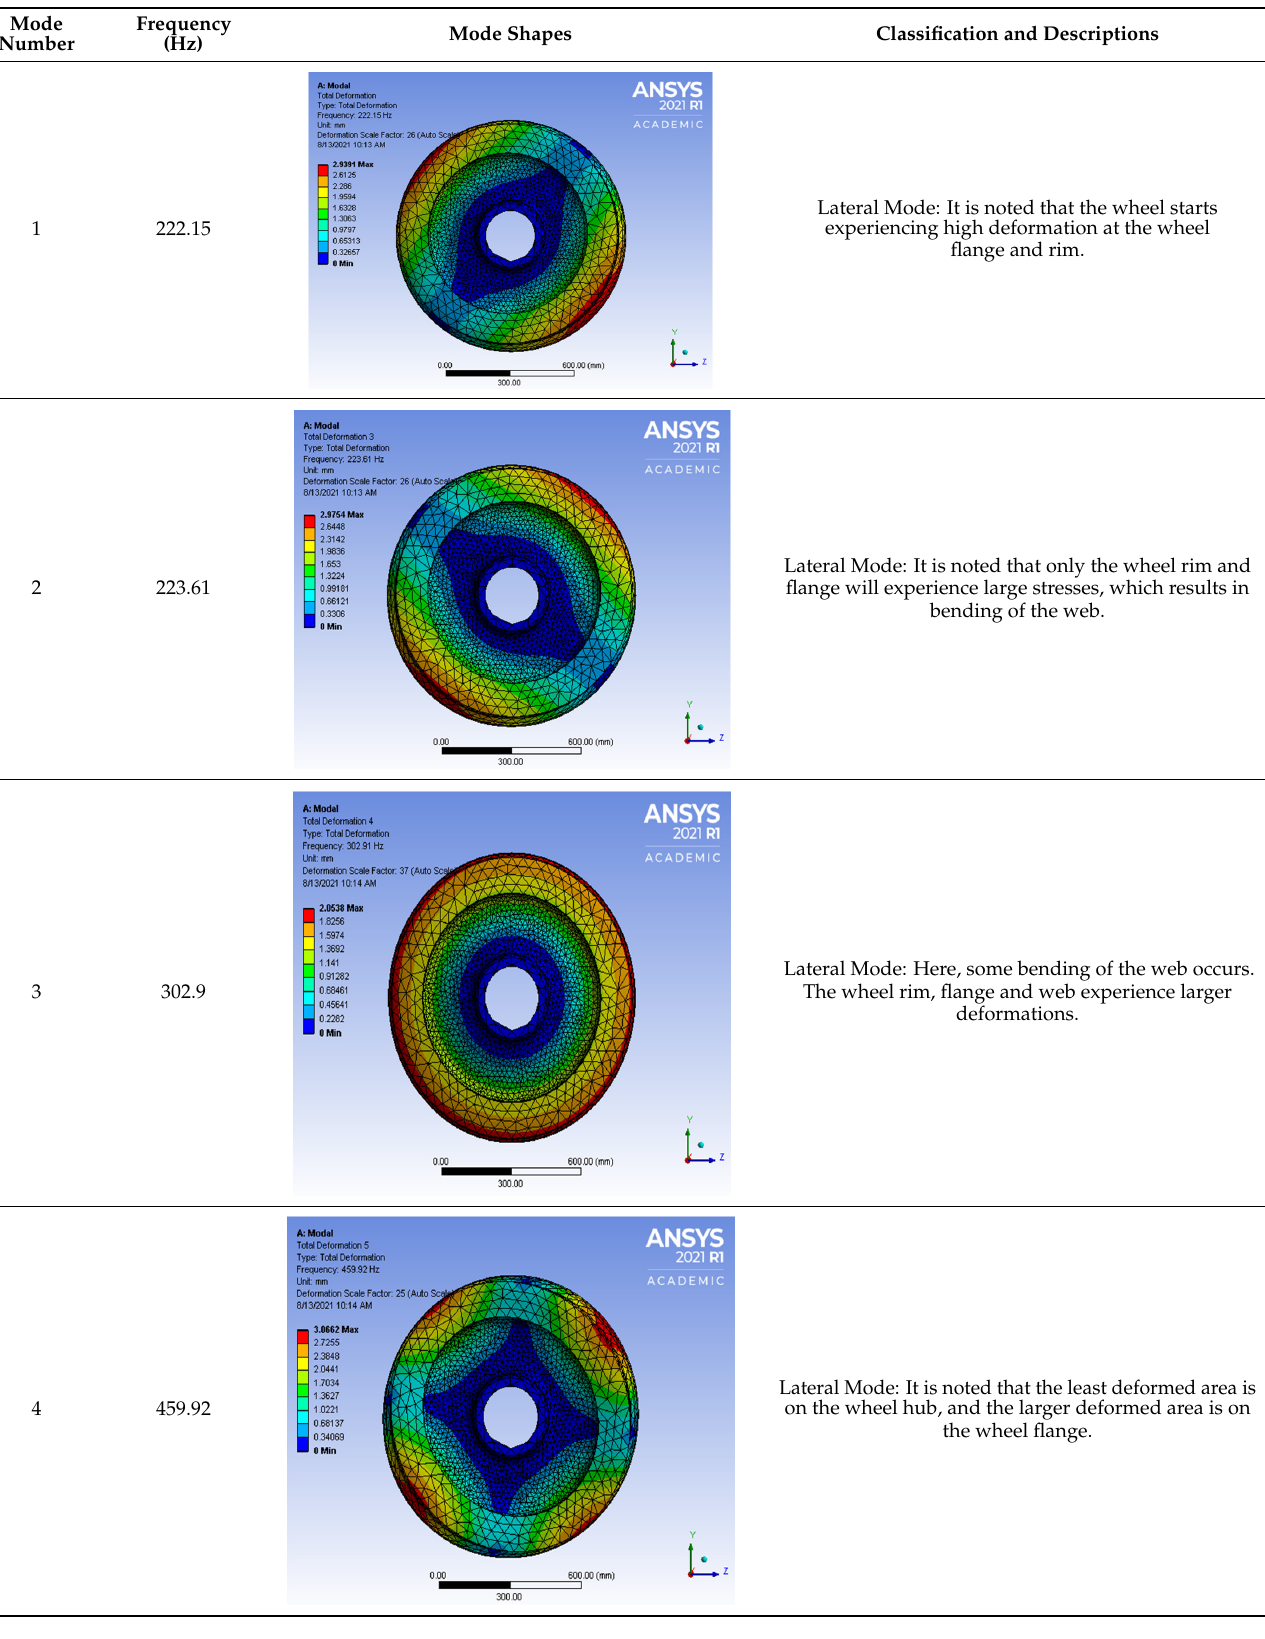
Table A1. Natural frequency and mode shapes for D39 200 locomotive wheel.